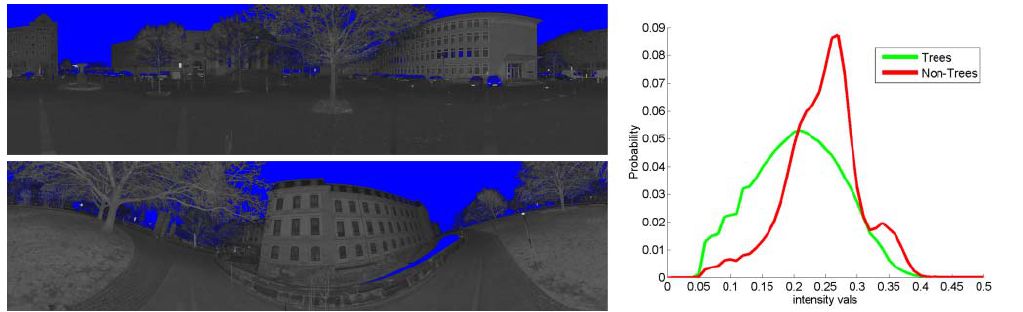
Figure 7. The intensity channel, and the intensity values tree/non-tree distribution.